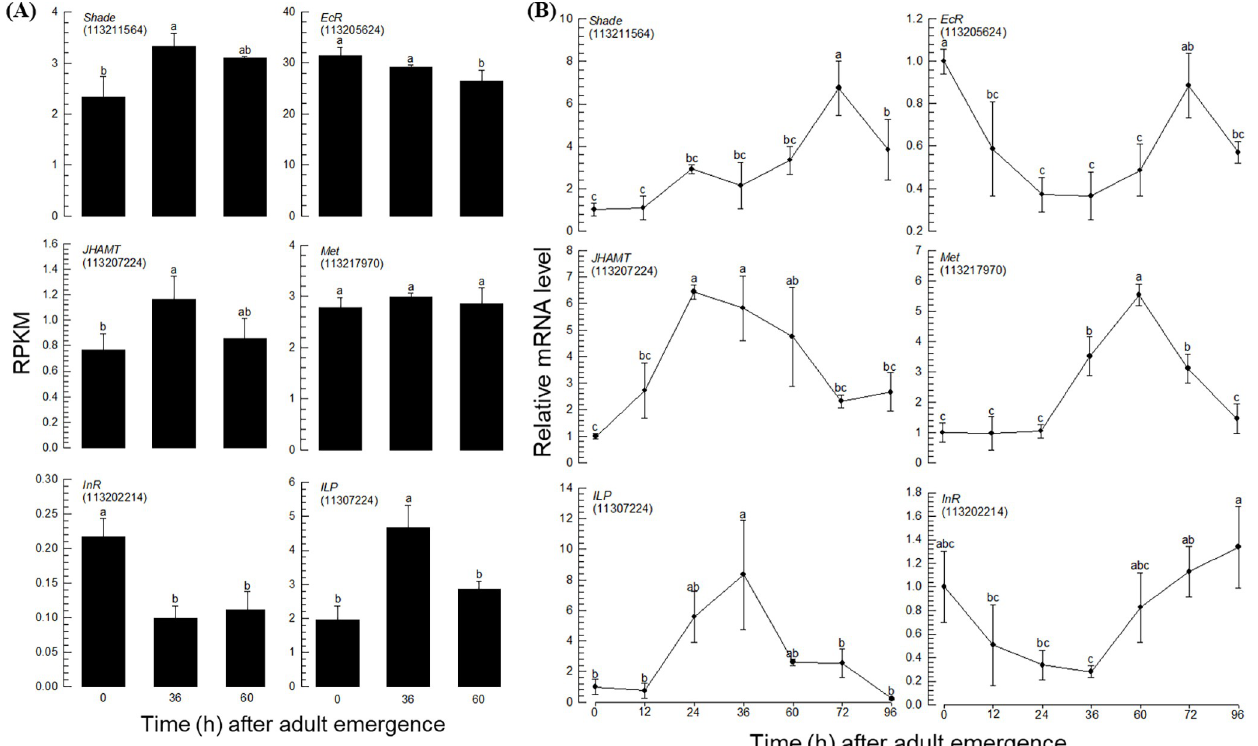
Fig 5. Expression analysis of the selected endocrine signal genes during F . occidentalis ovarian development. The NCBI Gene ID is in each parenthesis. (A) RNASeq analysis. (B) RT-qPCR analysis. Each measurement was replicated 3 times. The figures in parentheses indicate LOCs, which are the NCBI gene IDs. Different letters above the standard deviation bars represent significant differences among the means at type I error = 0.05 (DMRT test).